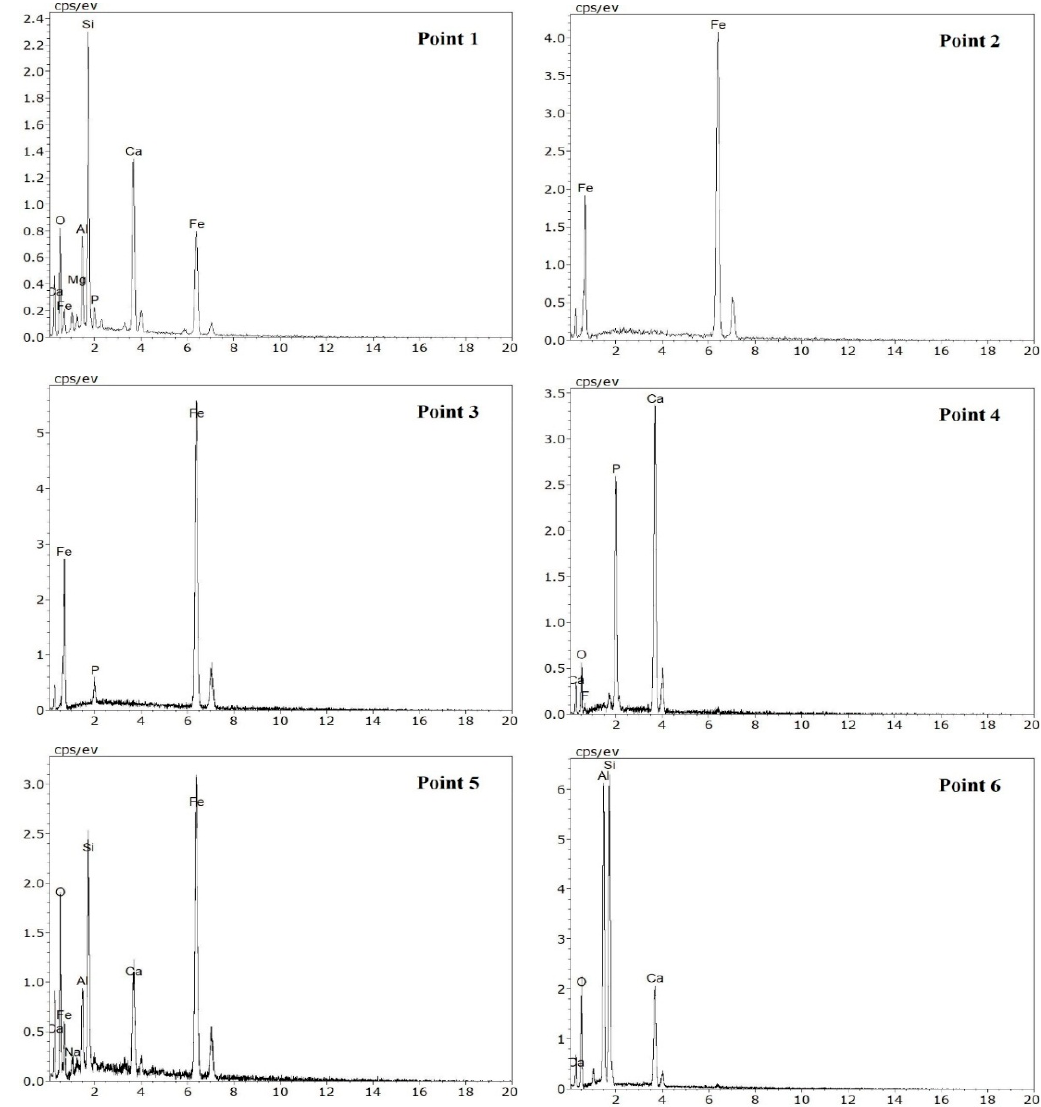
Figure 4. SEM-EDS analysis results of different briquettes. ( a ) 20 wt. % R 1 as reductant; ( b ) 30 wt. % R 1 as reductant; ( c ) 20 wt. % R 2 as reductant; ( d ) 20 wt. % R 2 as reductant; ( e ) 20 wt. % R 3 as reductant; ( f ) 30 wt. % R 3 as reductant. Point 1, 2, 3, 4, 5, and 6 were the results of point analysis in corresponding representative regions of Figure 4,